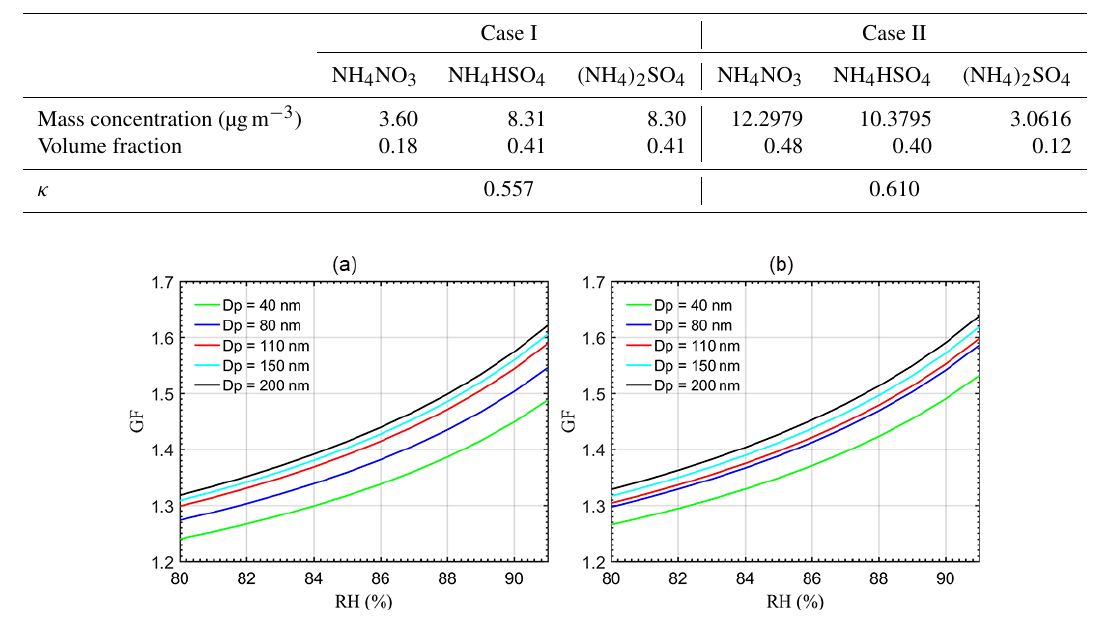
Figure 9. Aerosols size hygroscopic growth factor (GF) as a function of relative humidity (RH) for (a) Case I and (b) Case II. The different colors represent different particle sizes (Dp). These are the results of a model based on Eq. (3) from Gysel et al.